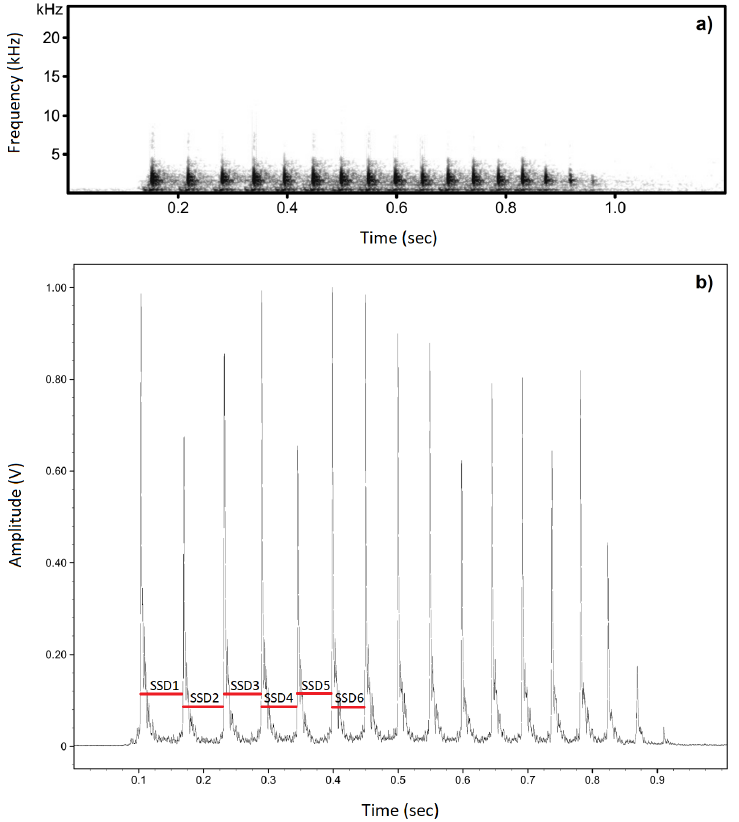
Fig 1. Spectrogram of great spotted woodpecker drumming. (a) Spectrogram represents one roll of drumming. (b) Pulse Train Analysis window with visible strokes within drumming roll (first six stroke-to-stroke durations are indicated). Spectrogram settings: FFT length = 512; Frame size = 75%, Window = Hamming.